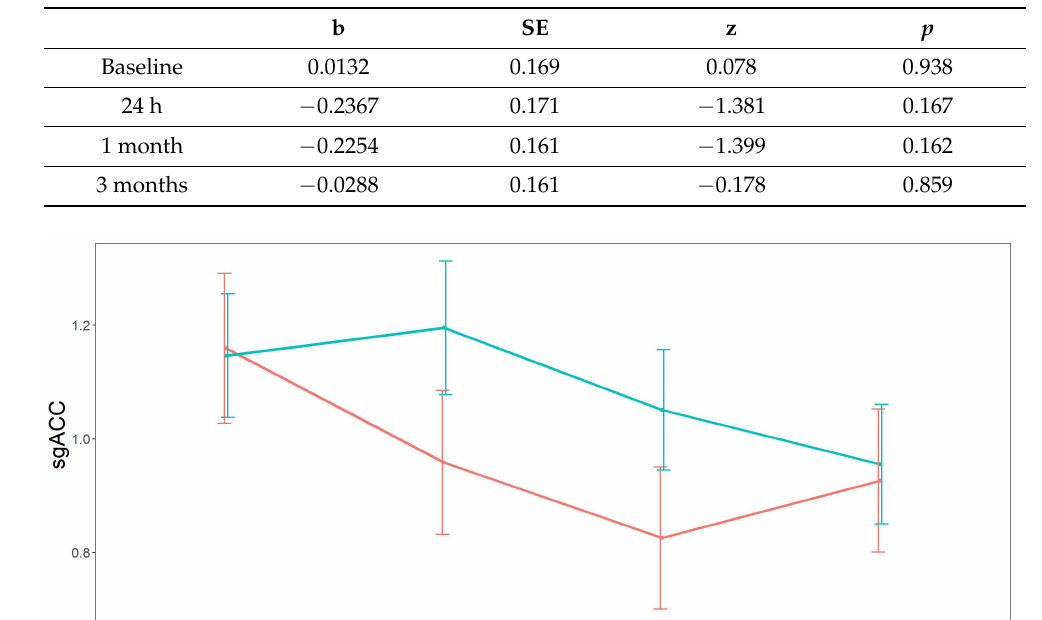
Table 4. Statistics for contrasts between 5-active sessions vs. 20-active sessions treatment at each individual time moment. p -values are corrected for multiple comparison using the Bonferroni method.